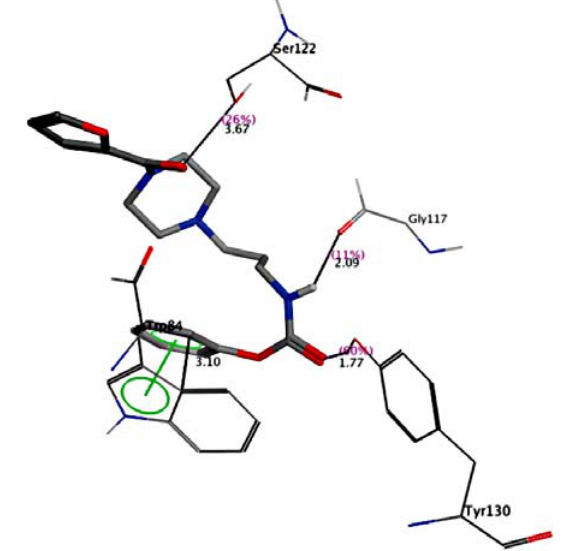
Fig. 5. 3D interacted image of phenyl 3- [ 4-(2-furoyl)-1-pipera- zinyl ] propylcarbamate ( 12 ) against acetylcholinestrase.